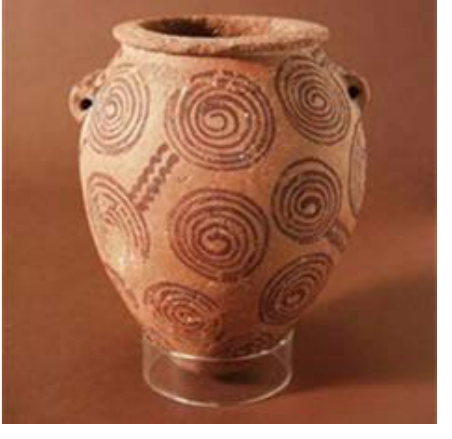
Figure 4-1: Pottery, Predynastic period Figure 4-2: Pottery, Predynastic